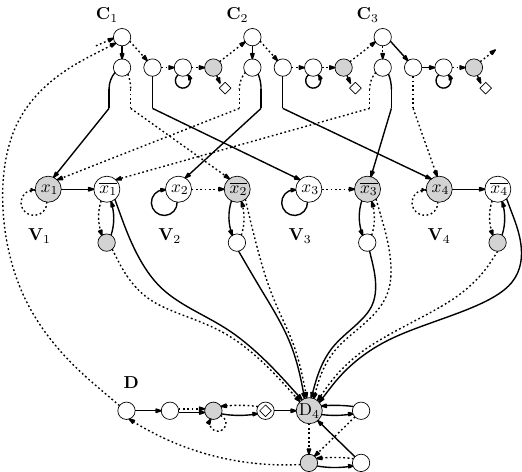
Fig. 7: An example of G Φ for Φ = ( x 1 ∨ x 2 ∨ x 3 ) ∧ ( x 1 ∨ x 2 ∨ x 4 ) ∧ ( x 1 ∨ x 3 ∨ x 4 ) . The filling marks the states that are active after applying y 1 y 2 = ab